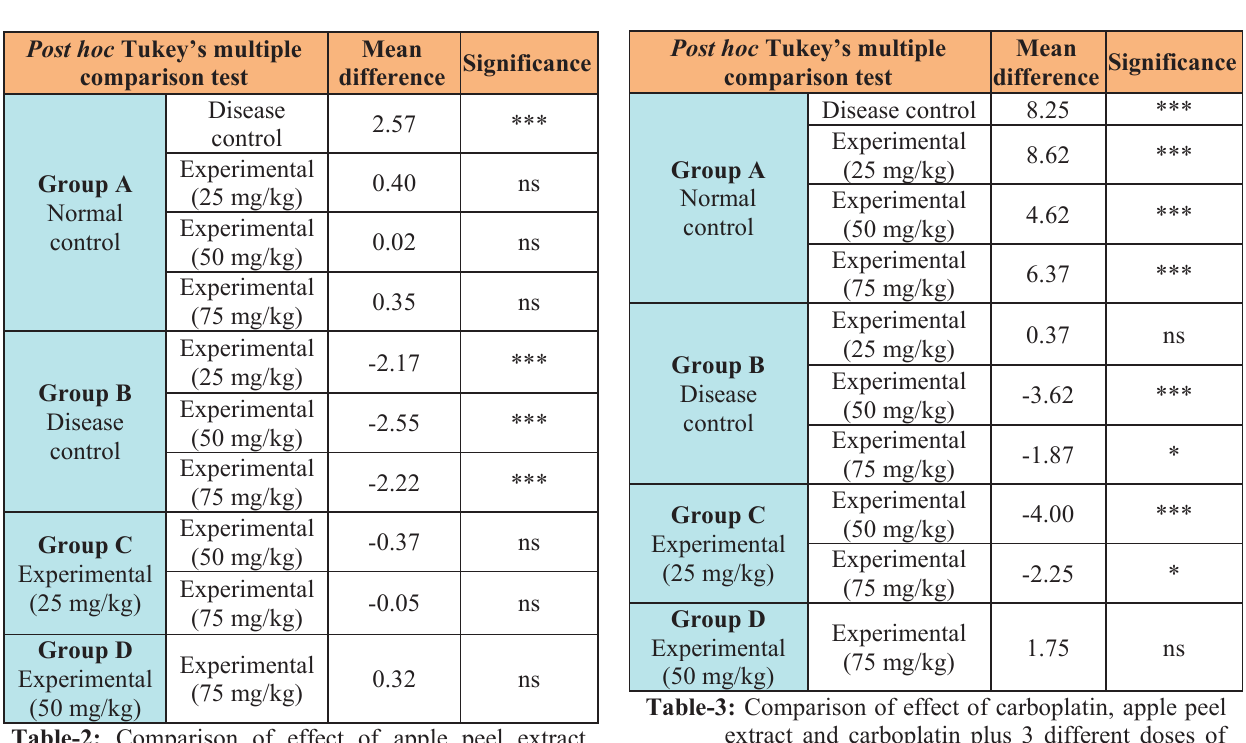
Fig-2: Effect of carboplatin and carboplatin plus 3 different doses of apple peel extract on erythroid cell percentage (Mean ± SD) in bone marrow aspirate smear of mice (n=8) *** = p value <0.001 (vs Normal Control), ** = p value <0.01 (vs Normal Control), … = p value <0.001 (vs Disease Control)